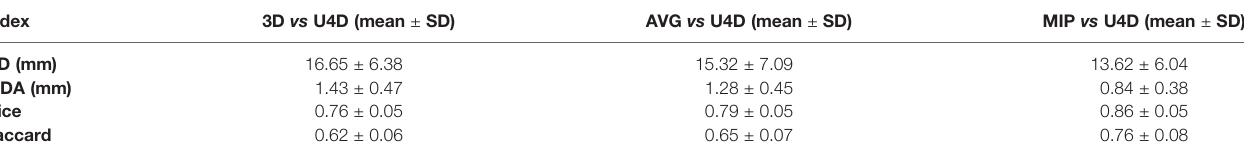
TABLE 2 | Mean HD, MDA, Dice, and Jaccard coef fi cients between 3D, AVG, MIP, and U4D contours.